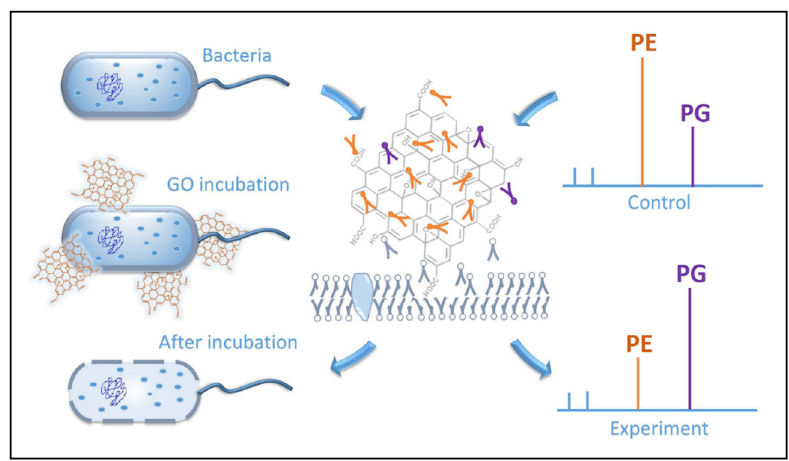
Figure 20: Schematic illustration of the antibacterial activity of graphene oxide ( GO )- based on mass spectrometry [ 157 ] . Copyright 2016, Scienti fi c